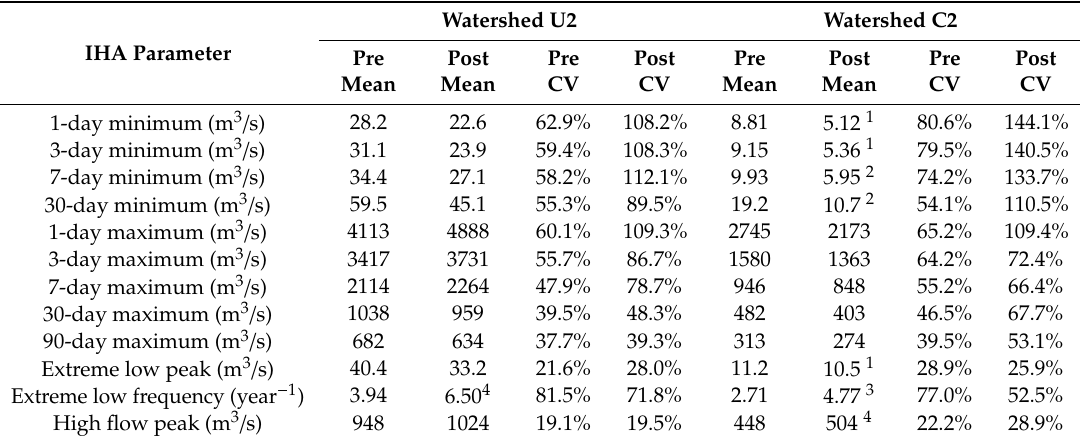
Table 4. Results of two-period IHA analysis with positive change in mean values indicating an increase after urbanization for watersheds in Georgia. Coe ffi cients of variation (CV) are given for the before (Pre) and after (Post) urbanization periods. Footnotes indicate the significance level of the trend from one period analysis. Only parameters with a significant trend for at least one watershed are presented.